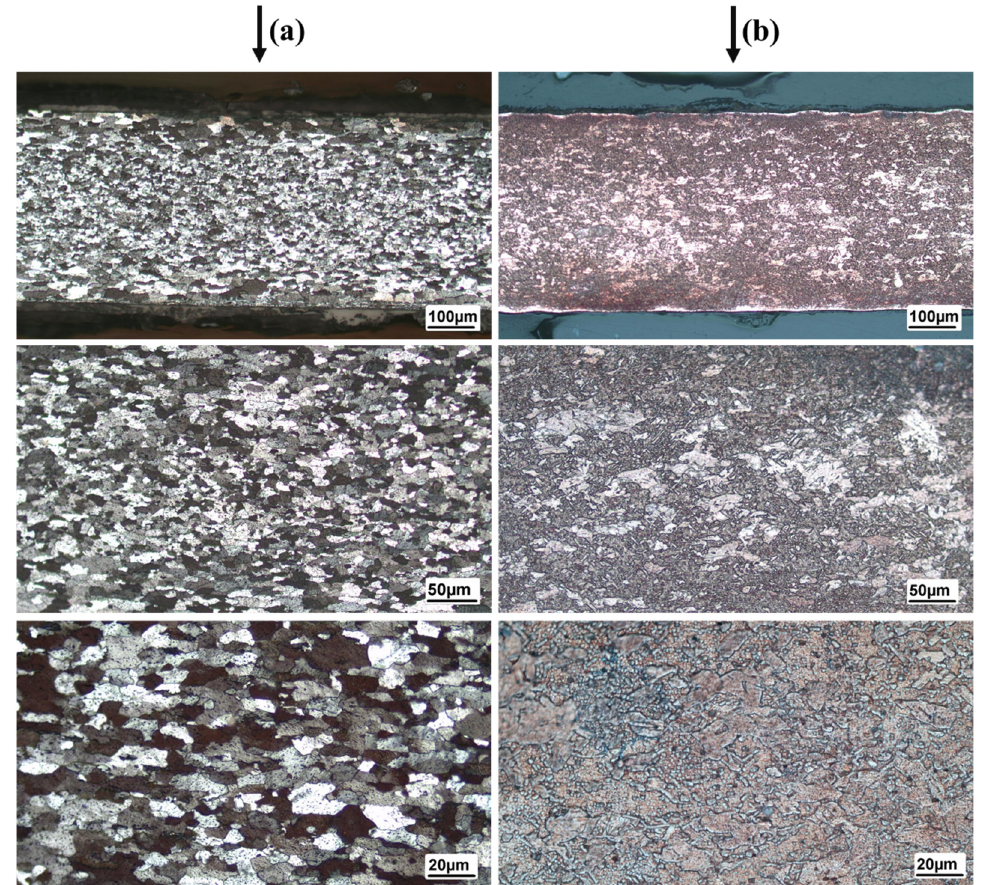
Figure 2. OM images of initial sheets of: ( a ) Al and ( b ) Cu.